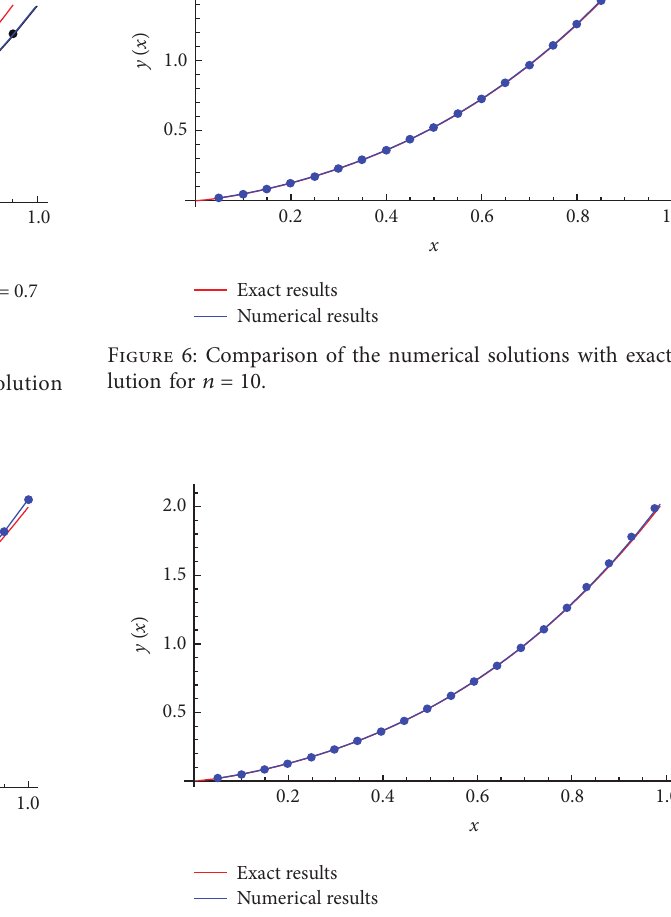
Figure 4: Comparison of the numerical solutions with exact so- lution for n � 6.